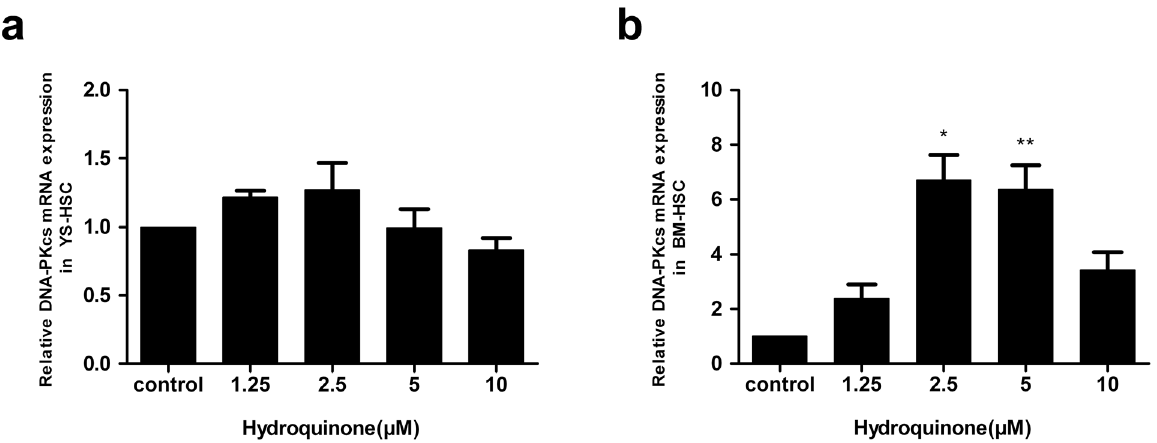
Figure 9. Effect of hydroquinone on DNA-PKcs mRNA expression. YS-HSC (a) and BM-HSC (b) cells were treated with HQ at increasing concentrations and expression of DNA-PKcs mRNA was measured by quantitative real–time PCR. The relative expression of target genes was calculated using the 2 2 DD Ct method. Data represent means 6 SDs of at least three individual experiments (*, P , 0.05; **, P , 0.01; and # , P , 0.001; compared to control group